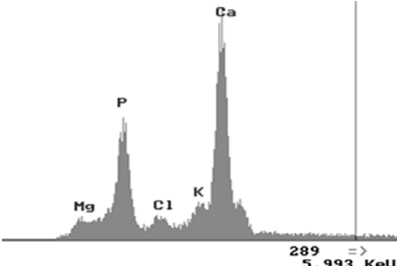
Figure 3. EDX spectra of HA coated Mg Sample (i).